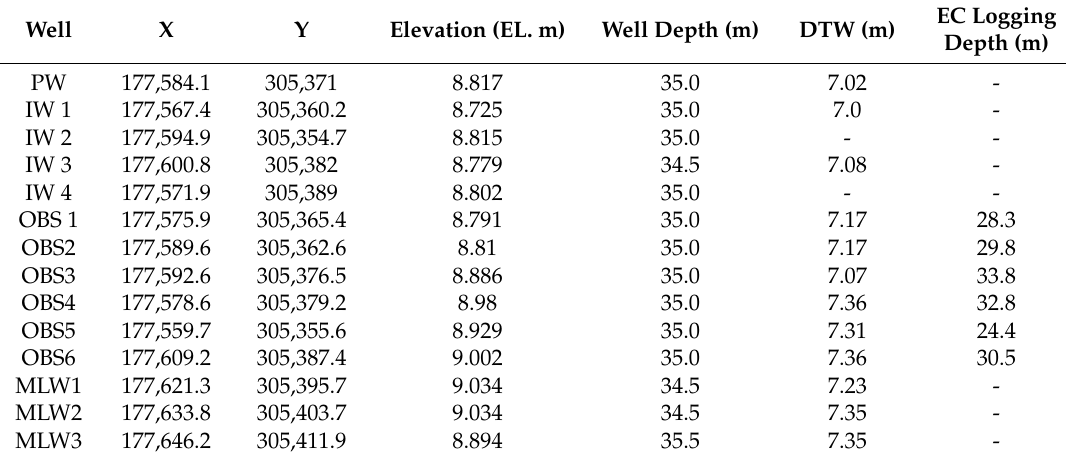
Table 1. Pumping, injection, and observational wells in the study